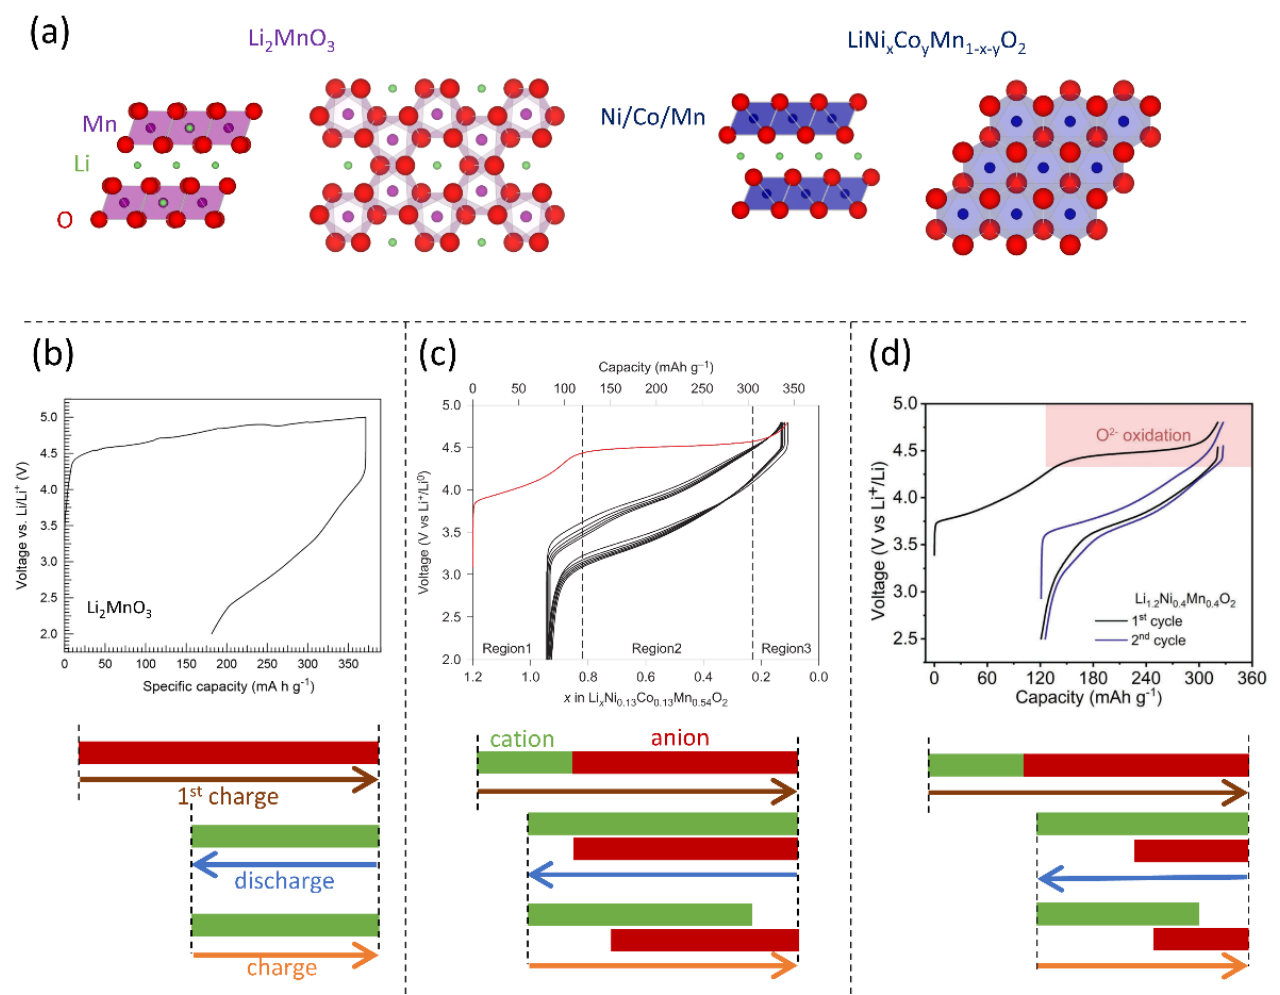
Figure 6. ( a ) The crystal structures of Li 2 MnO 3 and LiNi x Co y Mn 1-x-y O 2 . The charge-discharge curves and redox evolution of ( b ) Li 2 MnO 3 , ( c ) Li 1.2 Ni 0.13 Co 0.13 Mn 0.54 O 2 , and ( d ) Li 1.2 Ni 0.4 Mn 0.4 O 2 . Reproduced